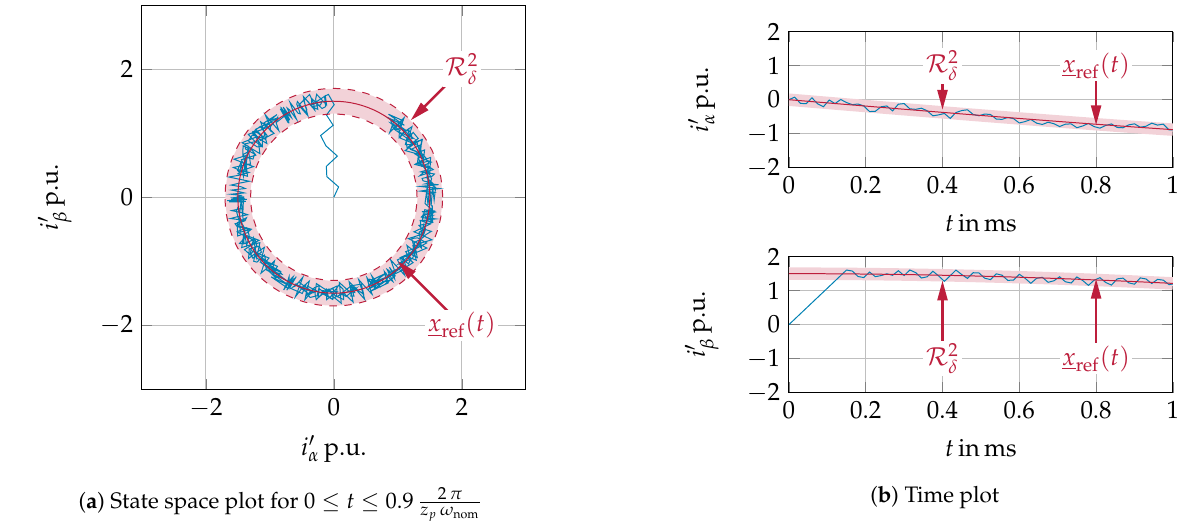
Figure 12. State trajectory x ( t ) for reference trajectory x ref ( t ) by (62) and initial value x 0 by (63).